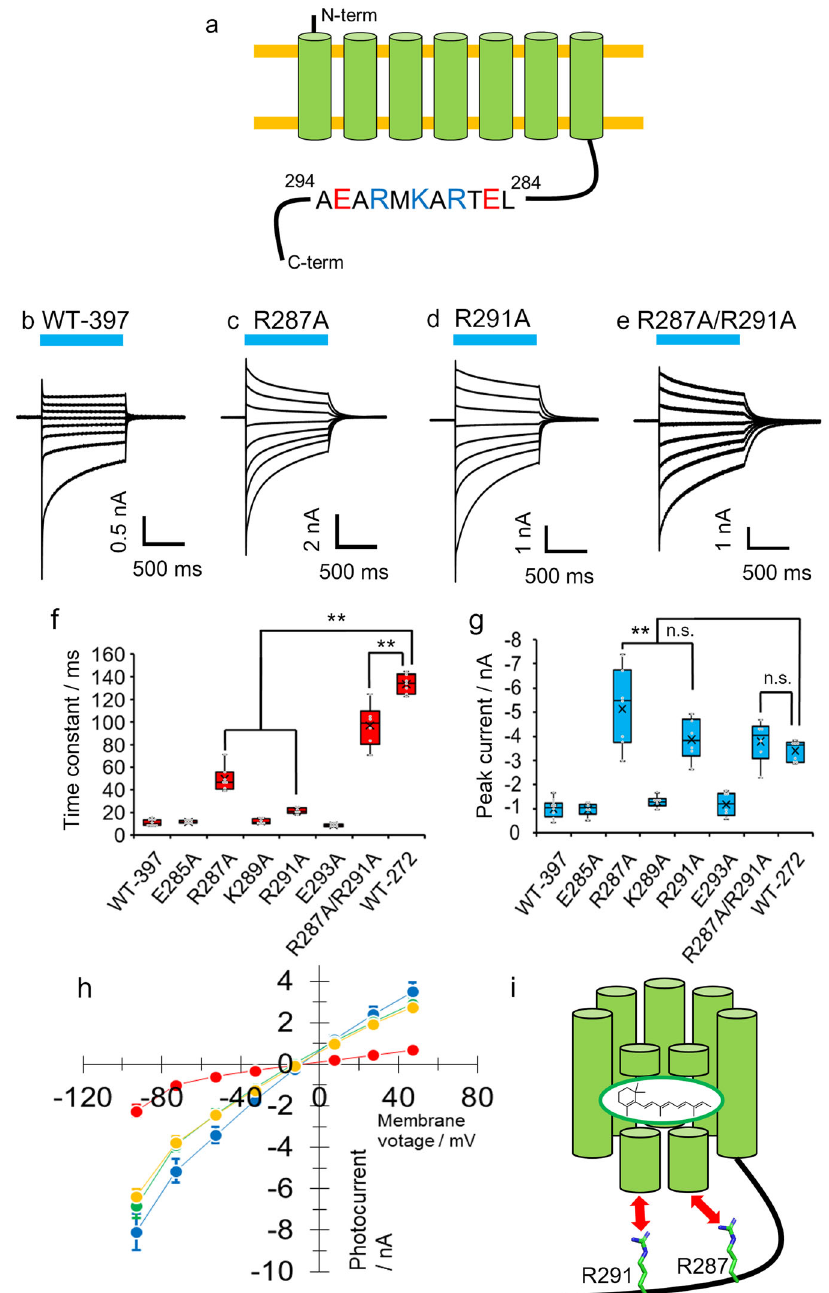
Fig. 3 Electrophysiological measurements of variants in the C-terminal region. a Schematic drawing of KnChR with amino acid sequence between 284 and 294. b – e Photocurrent traces of KnChR-397 (no mutation), mutant variants- R287A, -R291A, and -R287A/R291A respectively. Blue bars indicate light application (480 nm, 12.3 mW/mm 2 ). Membrane voltage was clamped from at − 90 to + 50 mV by 20 mV steps. Standard solutions were used (See “ Methods ” ). f , g Comparison of time constants and peak current amplitude. The membrane voltage was clamped at − 70 mV. N = 9 (WT-397), 6 (E285A), 7 (R287A), 6 (K289A), 6 (R291A), 6 (E293A), 6 (R287A/R291A), and 7 (WT-272). h I-V relationship of KnChR-397 (red)( N = 9), -R287A (blue)( N = 7), -R291A (green)( N = 6), and – R287A/R291A (yellow)( N = 6). Data were presented as the mean ± SEM. i Schematic drawing of interaction between the 7- TM domain and the cytoplasmic region in Δ E rev measured after substituting the test ion for the control ion, but also on the actual concentrations of the two ions. Taking into account ion concentrations used for the measurements, we esti- mated permeability ratios (Table 1). KnChR actually exhibited far Fig. 6g. Reversal potentials and a shift in reversal potential ( Δ E rev ) greater relative permeability for H + than for the metal cations, as is typical of chlorophyte CCRs such as CrChR2. For example, the respectively. The relative permeability depends not only on the KnChR permeability ratio of Na + to H + (P Na + /P H + ) was